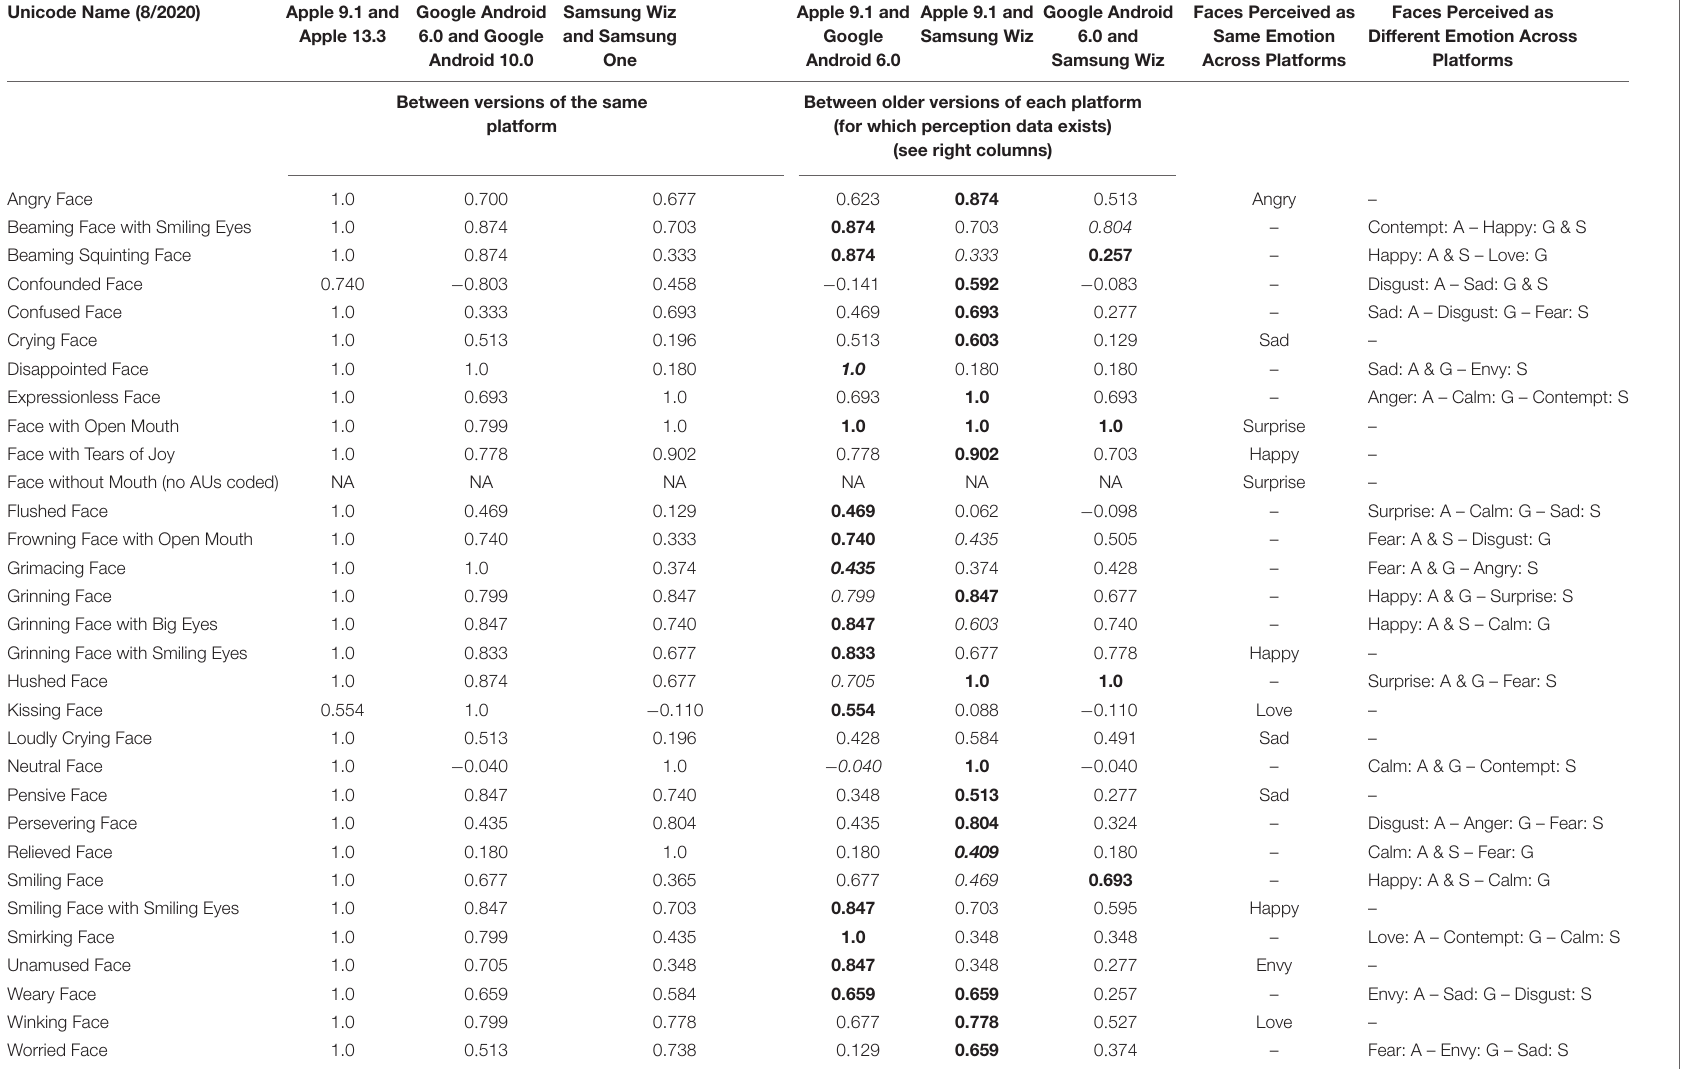
For columns labeled “Between older versions of each platform,” bold values represent the highest correlation coefficient between two platforms. For faces that were perceived as different emotions(s) among these platforms, the predicted highest correlation coefficient (based on shared perception) is in italics. For only the “relieved face” and the “disappointed face” was the prediction supported. A = Apple 9.1; G = Google Android 6.0; S = Samsung